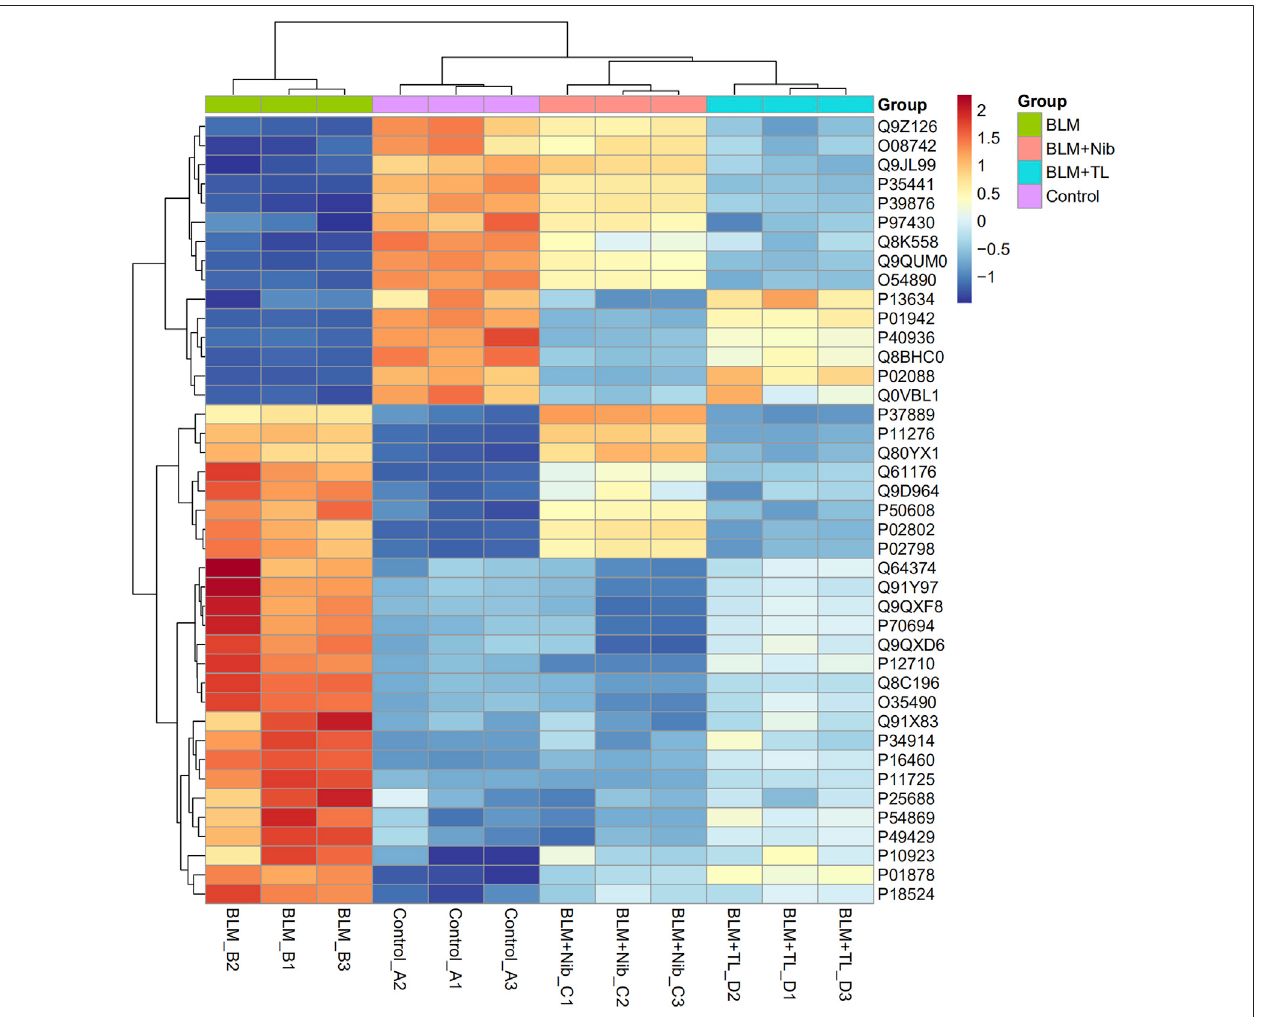
FIGURE 3 | Heatmap of the levels of differentially expressed proteins. The red-colored clusters represent up-regulated proteins, and the blue-colored clusters represent down-regulated proteins. The intensity of the color represents the degree of up-regulation and down-regulation. The expression of Arg1 (Q61176), OTC (P11725), and ASS1 (P16460) in BLM group were reversed after TL treatment.